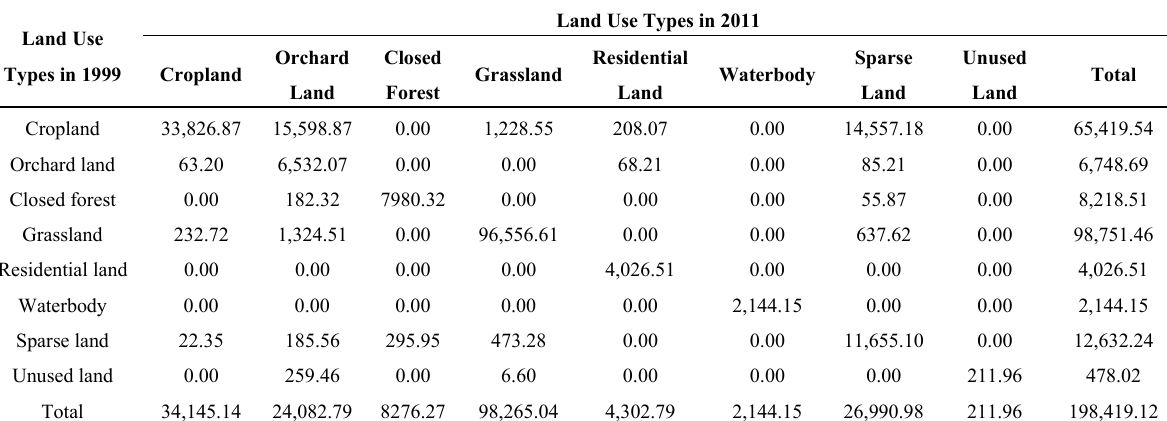
Table 5. Matrix of land use/cover changes during 1999–2011 (unit: